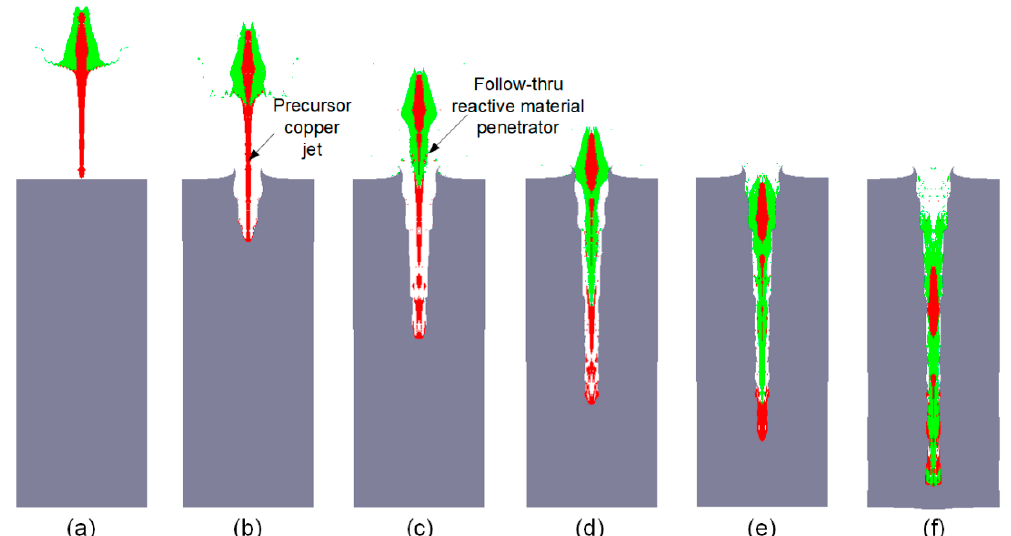
Figure 2. Typical penetration process of a RM-CL shaped charge impacting steel target: ( a ) Reactive material-copper jet (RM-CJ) formation characteristic before impacting; ( b ) precursor copper jet begins to penetrate the target; ( c ) and ( d ) show the head and slug of the reactive material penetrator starting to enter the penetration hole, respectively; ( e ) copper jet piles up and all reactive materials enter the target; and ( f ) shows the penetration at the termination stage.